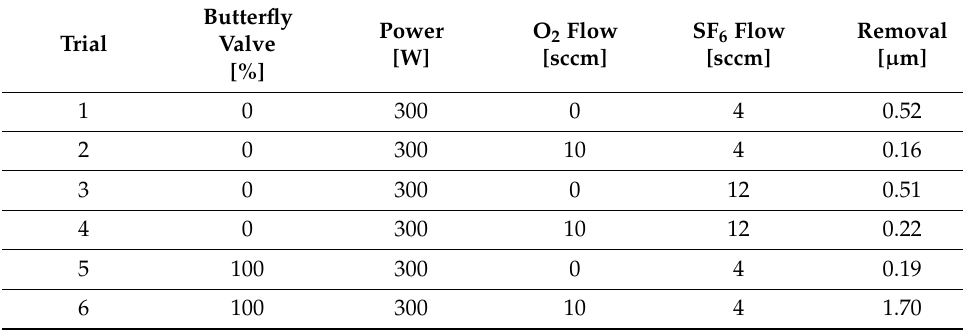
Table A2. Parametric analysis of